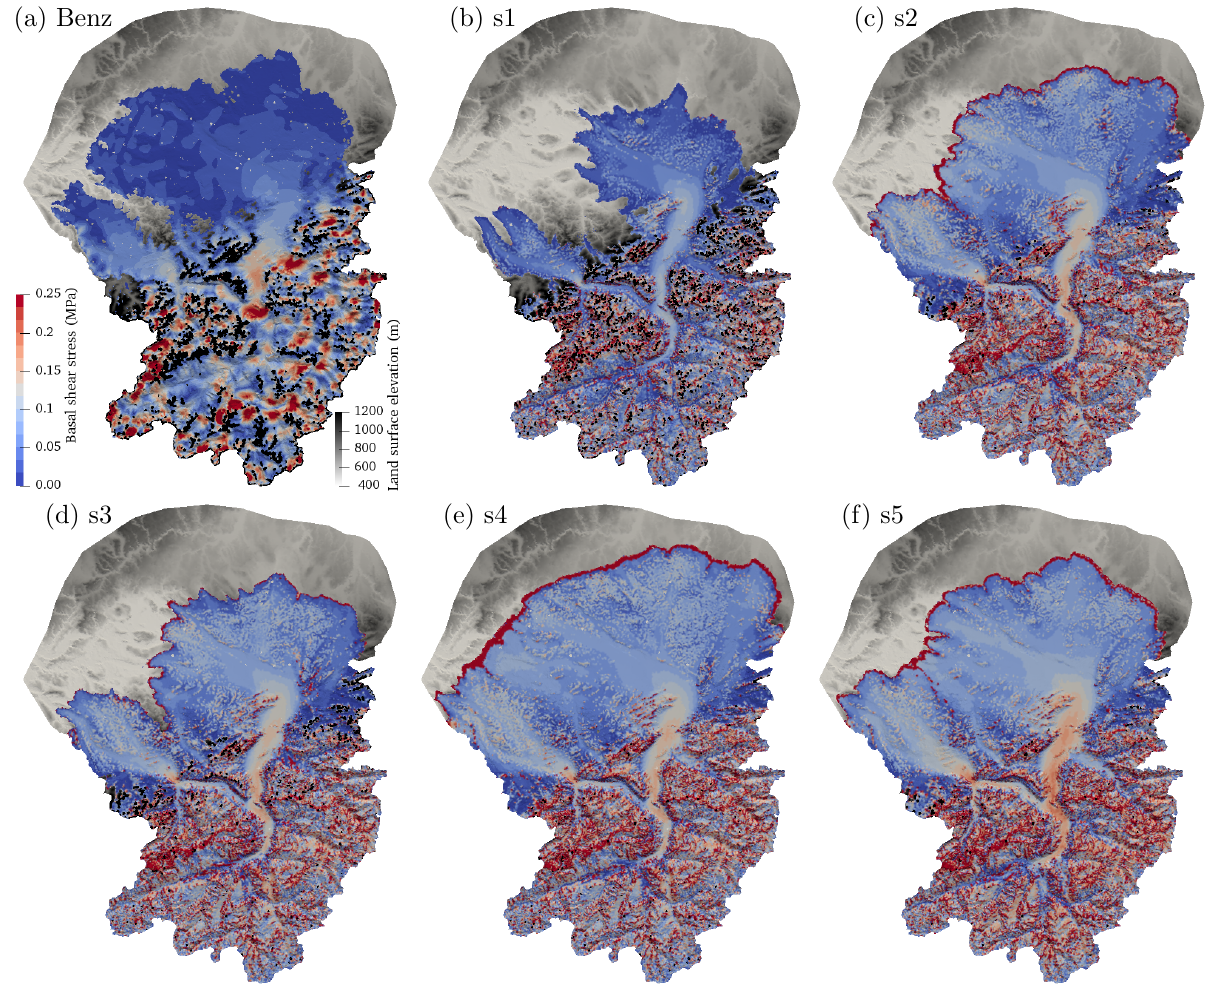
Figure 10. Basal shear stress in megapascals for (a) Benz-Meier (2003) (steady-state Stokes solution) and (b–f) simulations